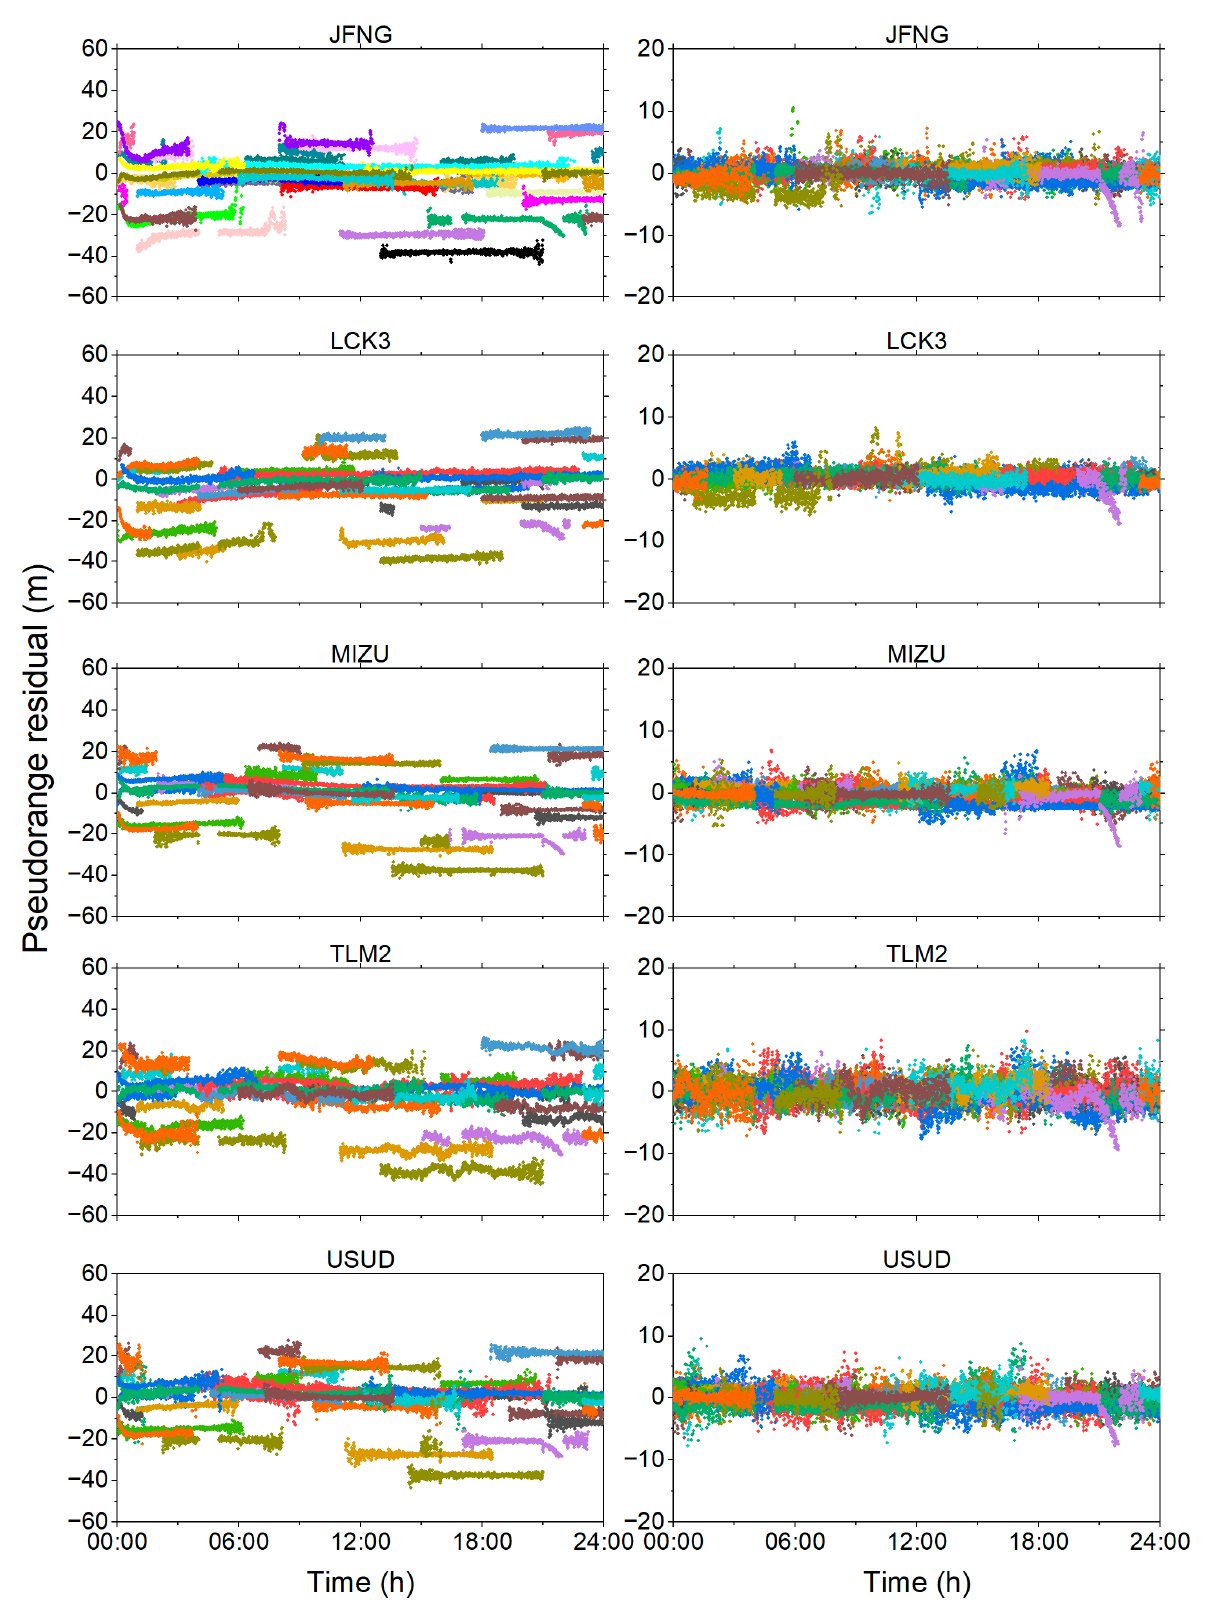
Figure 12. Pseudorange residual of B2b-RTPPP without ( left ) and with ( right ) DCB corrections. Each color represents a